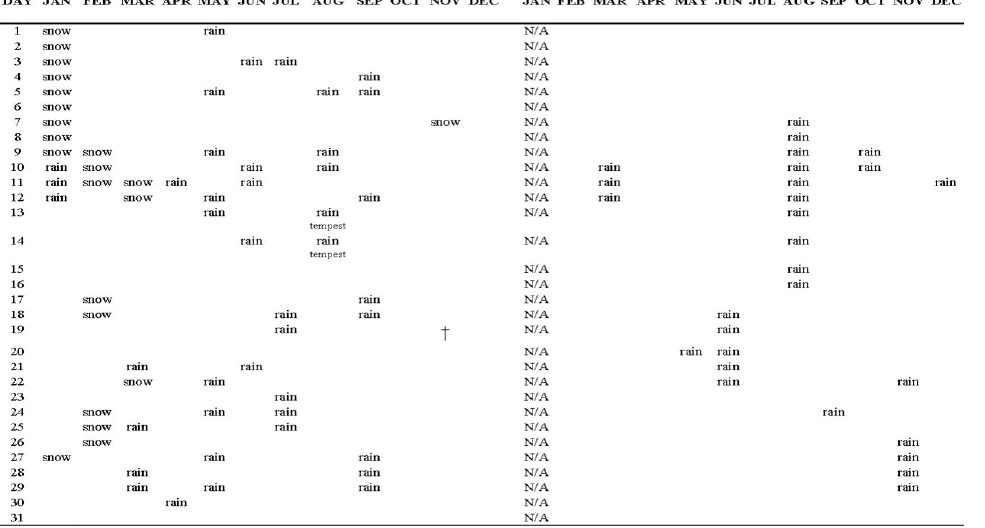
Figure 14. Number of days with precipitation (NPD) in Cracow (left) and Switzerland (right) derived from the weather diary of Marcel Biem (left) and from chroniclers situated in Switzerland and nearby Alsace and southern Germany (Wetter et al., 2014; Supplement).